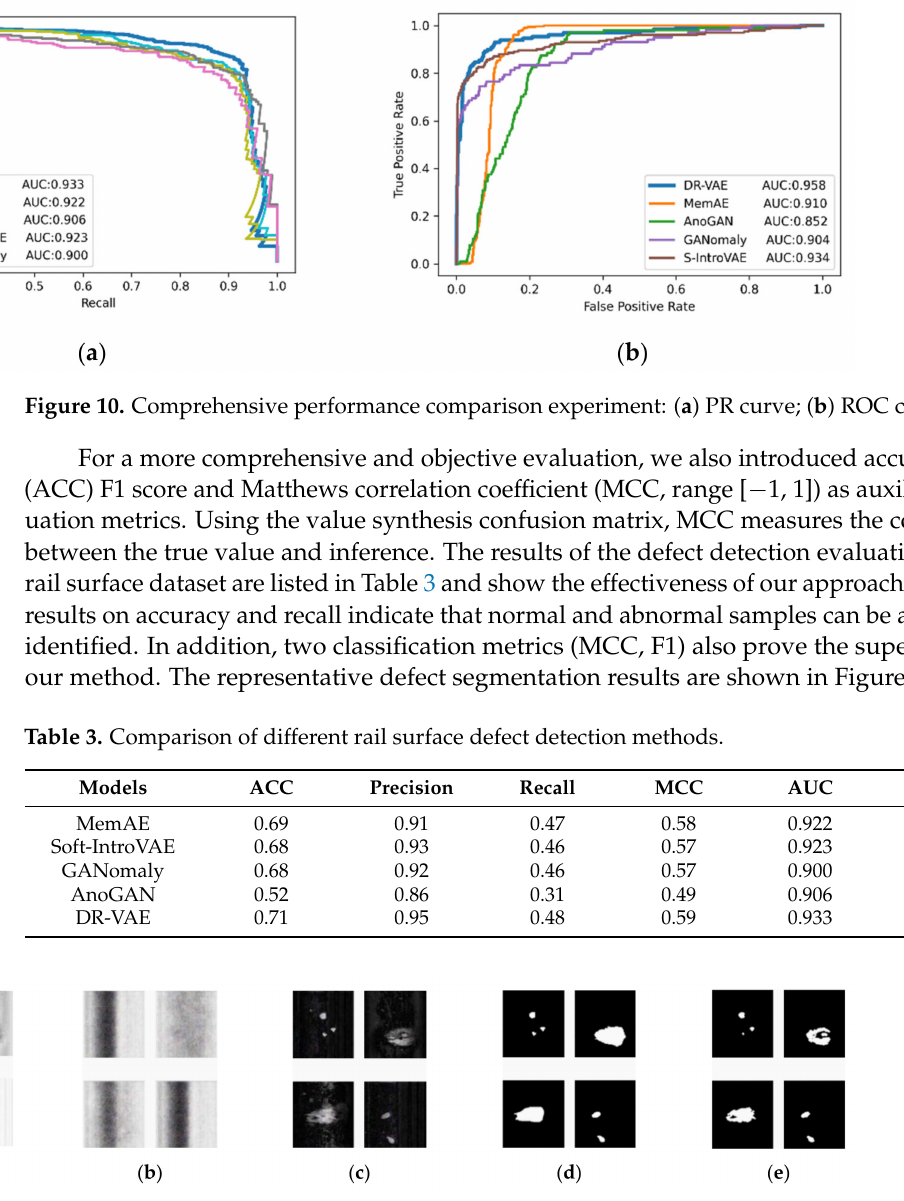
Figure 11. Representative defect segmentation results: ( a ) Rail surface image; ( b ) Reconstruction of images; ( c ) Residual images; ( d ) True value; ( e ) Our